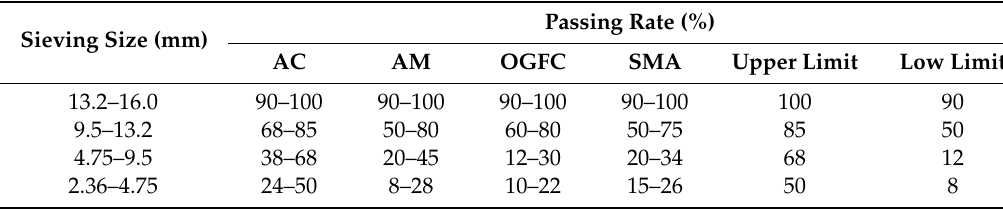
Table 1. Possible gradation scope of Gradation-13.